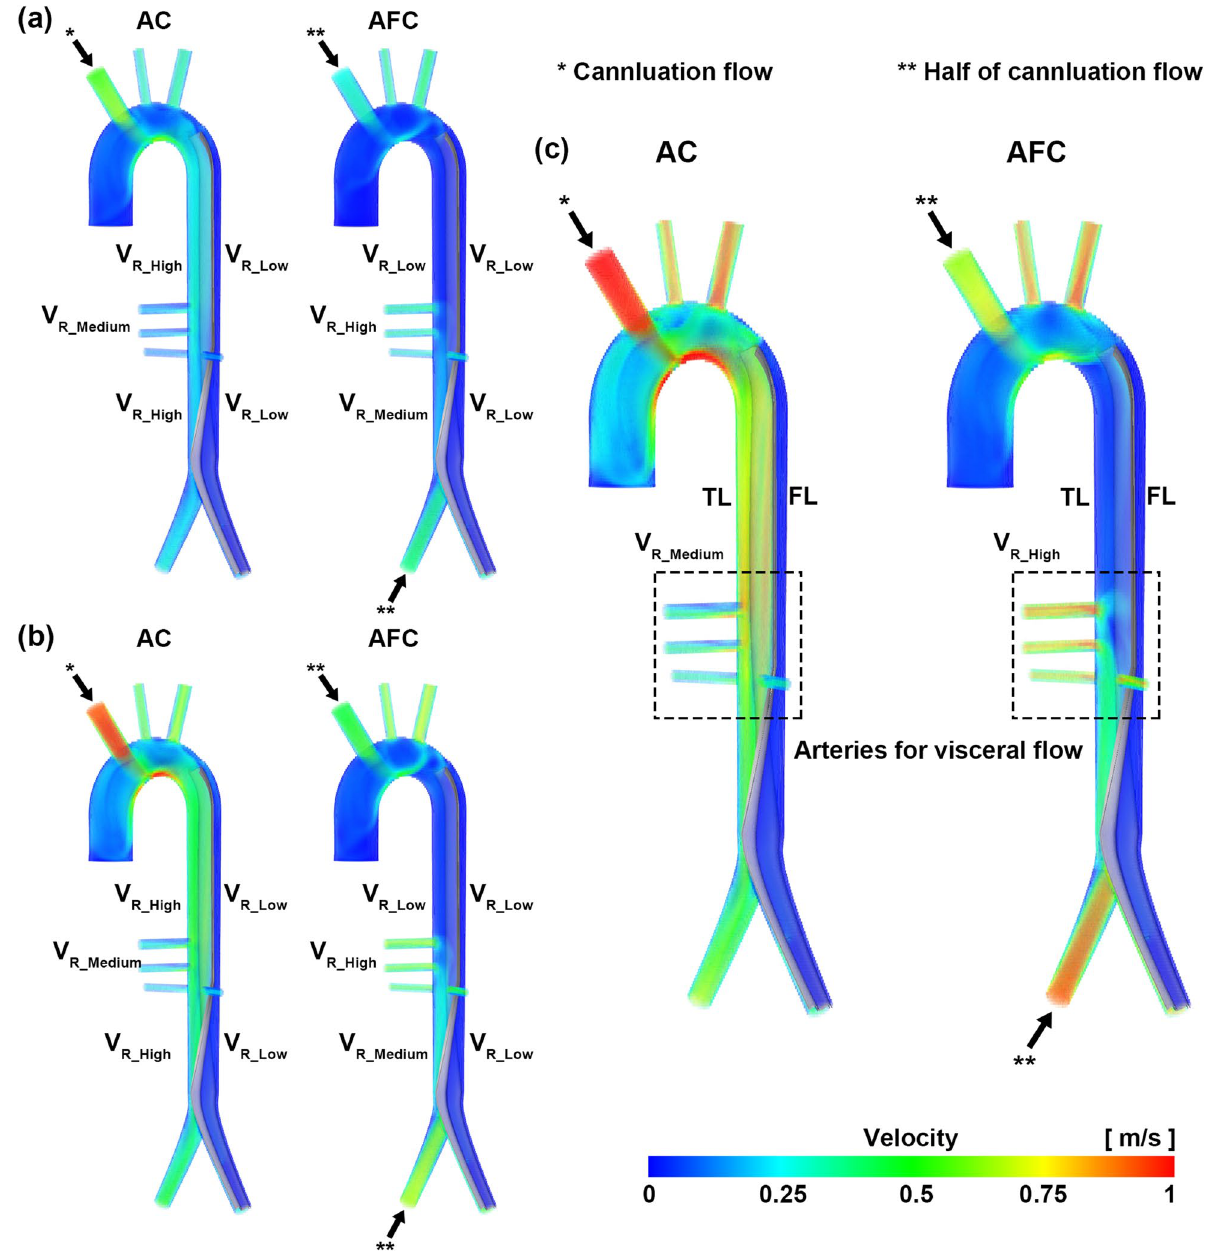
Figure 3. Velocity fields of AC and AFC. ( a ) 3 L/min, ( b ) 5 L/min, and ( c ) 7 L/min. These images were made with Ensight (v.2021 R1, https:// www. ansys. com) using the FSI false lumens were similar in all cases, and the intimal flap did not collapse toward the true lumen (Fig. 5). As the flow rate in AFC increased from 3 to 7 L/min, the pressure difference between true lumen and false lumen at the CA increased from 0.14 to 0.57 mmHg, and that at the SMA increased from 0.12 to 0.44 mmHg (Table 3). The area of the true lumen at the CA and SMA decreased from 98 to 97% (Fig. 6, Table 4). In the 4D flow MRI experiment, as the flow rate of AC increased from 3 to 7 L/min, the area of the true lumen of the intimal flap at the CA level decreased from 87 to 72% of the area, respectively, and at the level of the SMA, from 75 to 71%. As the flow rate in the SMA increased from 3 to 7 L/min, the area of the true lumen of the inti- mal flap at the level of the CA changed from 99 to 103%, and at the level of the SMA, from 99 to 104% (Table 4). Intimal flap stiffness and deformation. Figure 7 compares the maximum velocity and pressure results in the corresponding regions of the CFD with a rigid intimal flap and FSI simulations for an AC flow rate of 7 L/min. In the FSI simulation, the maximum velocity in the true lumen was higher than that in the rigid CFD, whereas the maximum velocity in the false lumen was lower than that in the rigid CFD in all six regions. Except